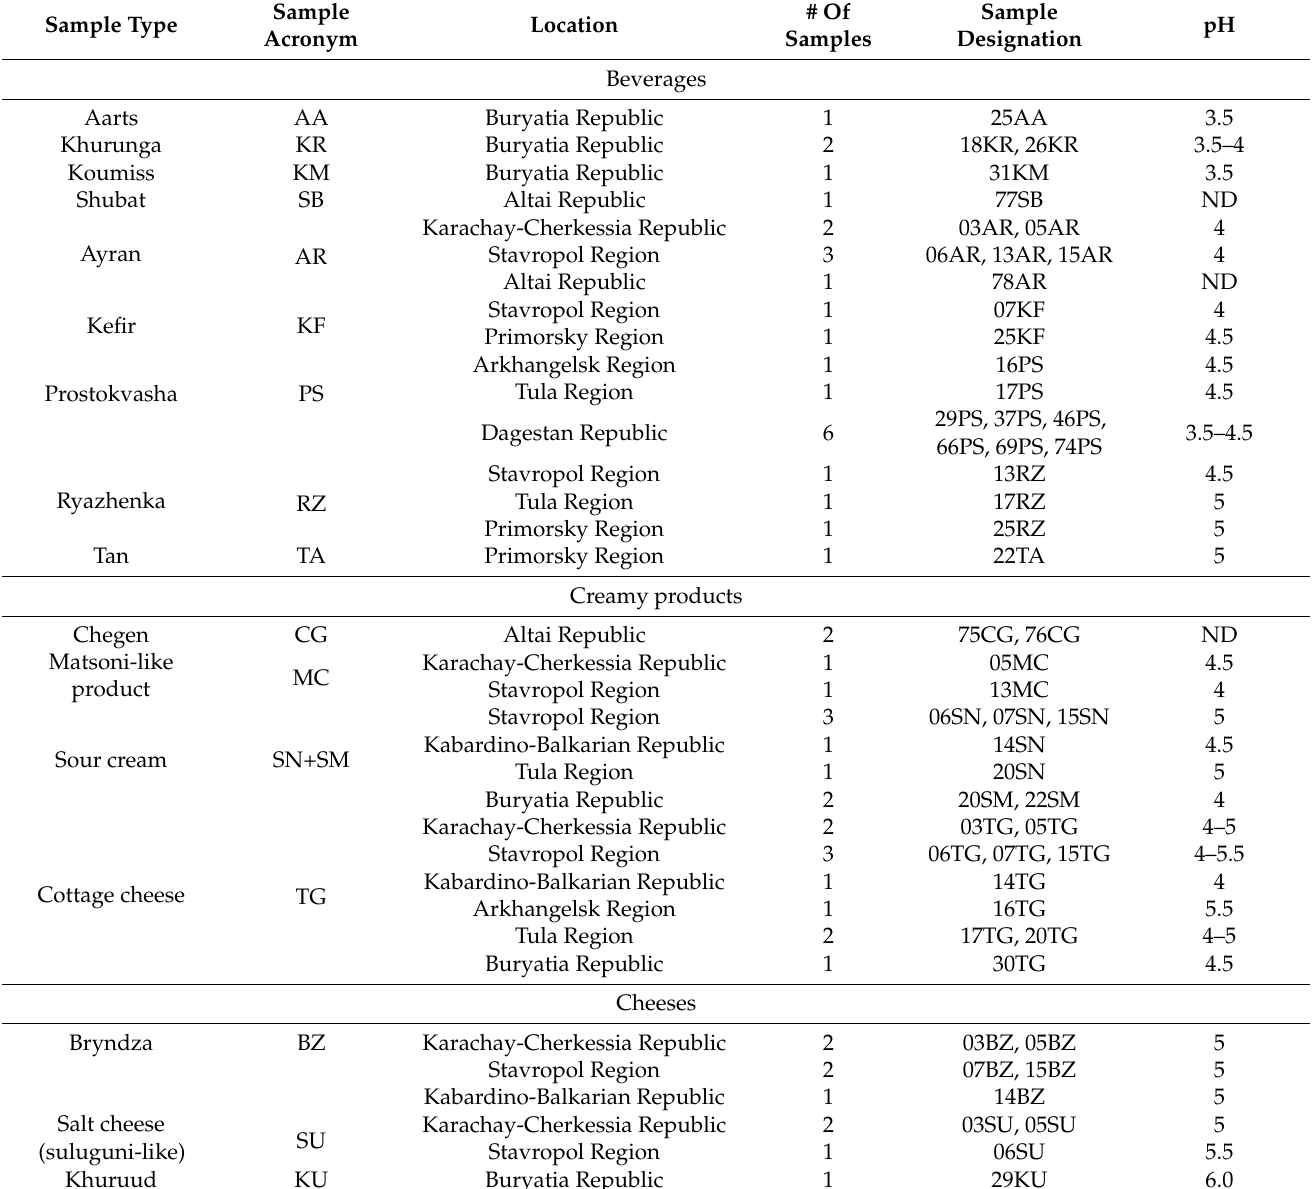
Table 1. Samples of fermented milk products, their location and